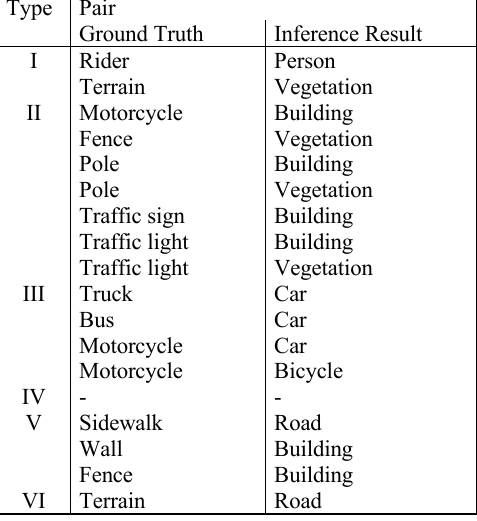
Table 7 . Types of false inference for pairs of ground truth elements and inferred classes of which RFIP>10%.